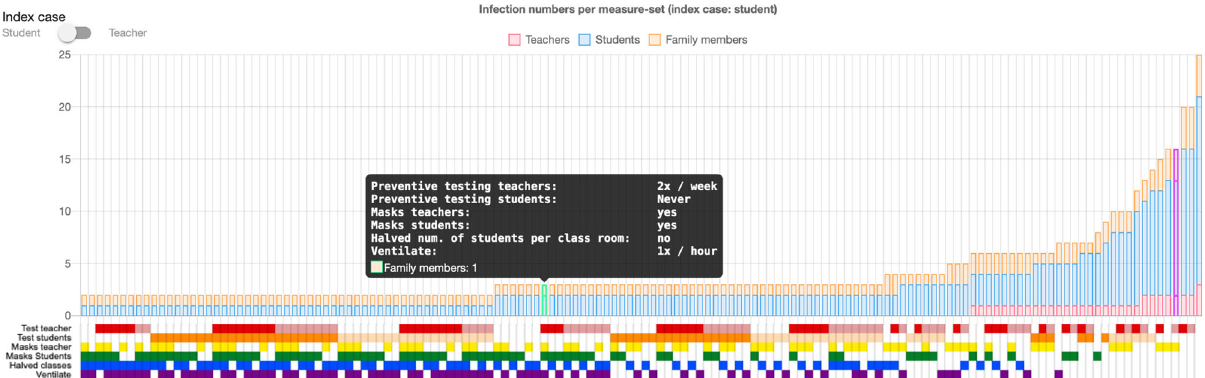
Fig. 9 Overview of the online interactive simulation viewer displaying the effects of measure combinations on cluster size. Each bar represents one set of measures. Bars are separated into three stacks, representing the number of infected students, teachers, and family members. The bar representing the currently selected set of measures is highlighted in purple (right). A popup window displays the measure con fi guration of a bar on mouse-over. Below the chart, six rows of coloured squares visually encode the set of measures that yielded the respective simulation result. A row (representing a measure) can be clicked, in order to re-sort the plot by the selected measure and thus enable a better comparison of the measure ’ s effects. The button on the top left corner allows a user to switch the results shown in the plot between simulations that had a student or a teacher as a source case.